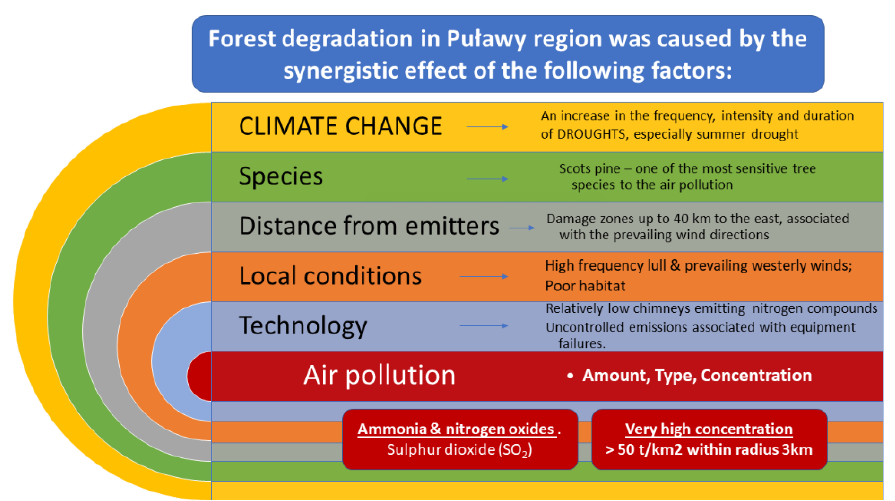
Figure 13. Factors determining forest degradation in Puławy region.